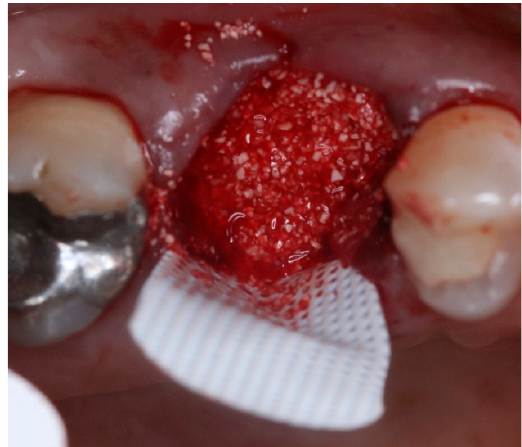
Figure 15. Intra-oral oclusal view of #16 after gaps filled with xenograft.